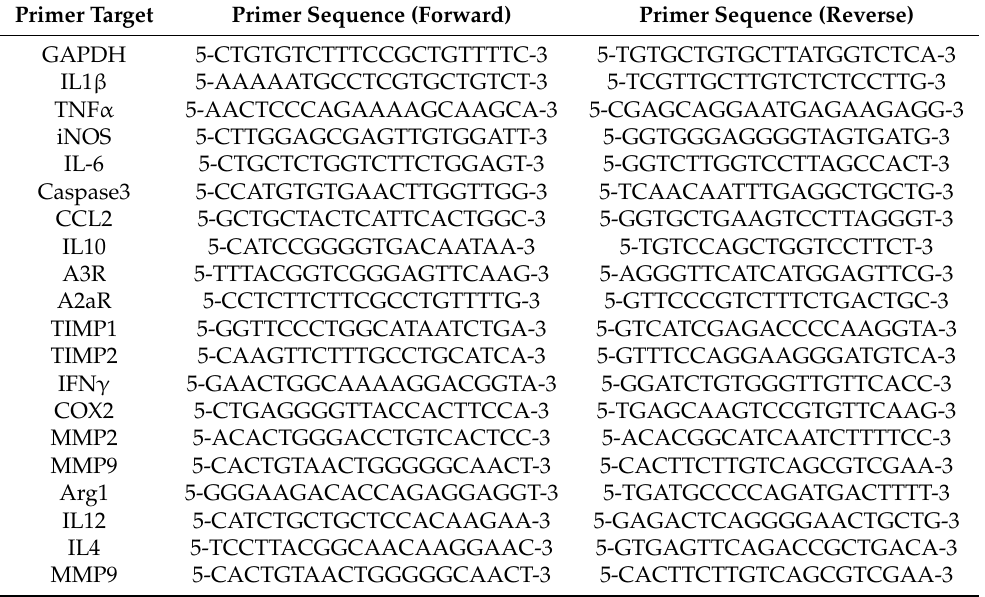
Table 1. This is a table. Tables should be placed in the main text near to the first time they are cited. Primer